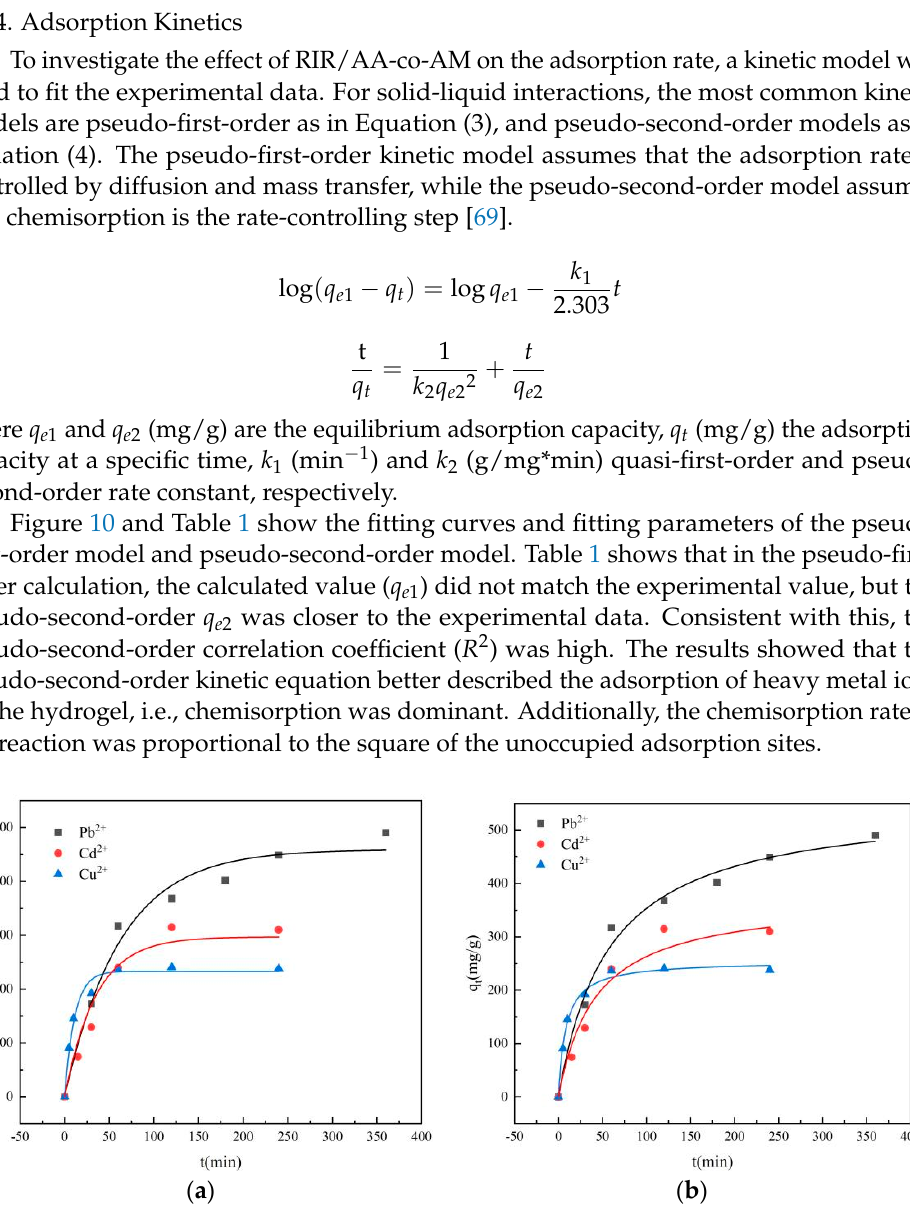
Figure 10. Pseudo-first-order ( a ), pseudo-second-order ( b ) kinetic model on heavy metal ions adsorption. Table 1. Kinetic parameters for the adsorption of heavy metal ions.